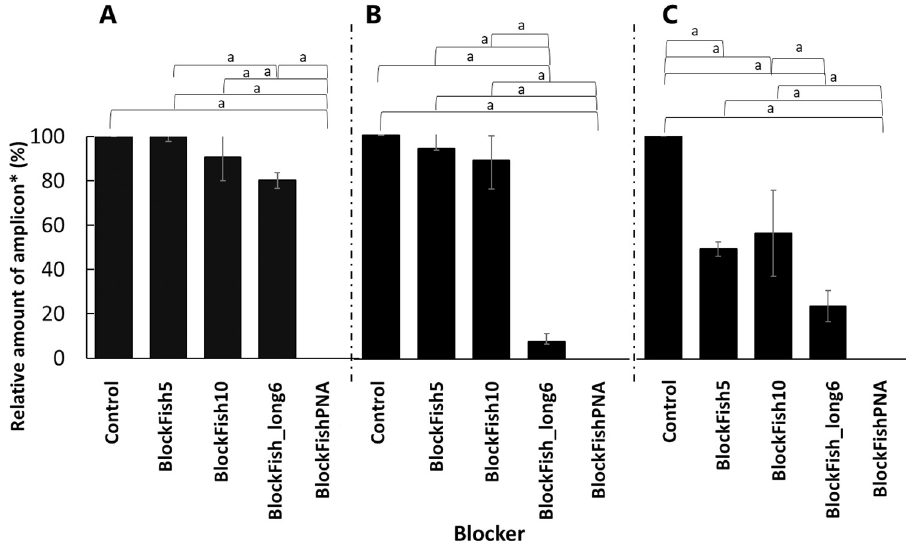
Fig 2. Suppression of fish 18S rDNA amplification with the blocking primers and PNA clamp. Annealing temperatures: A: 60˚C; B: 65˚C; C: 66˚C. Control: 18S rDNA amplification without the blocking primer or PNA clamp. a : Tukey–Kramer test: p < 0.01. � : Relative amount of amplicon when the amount of amplicon of the control was considered to be